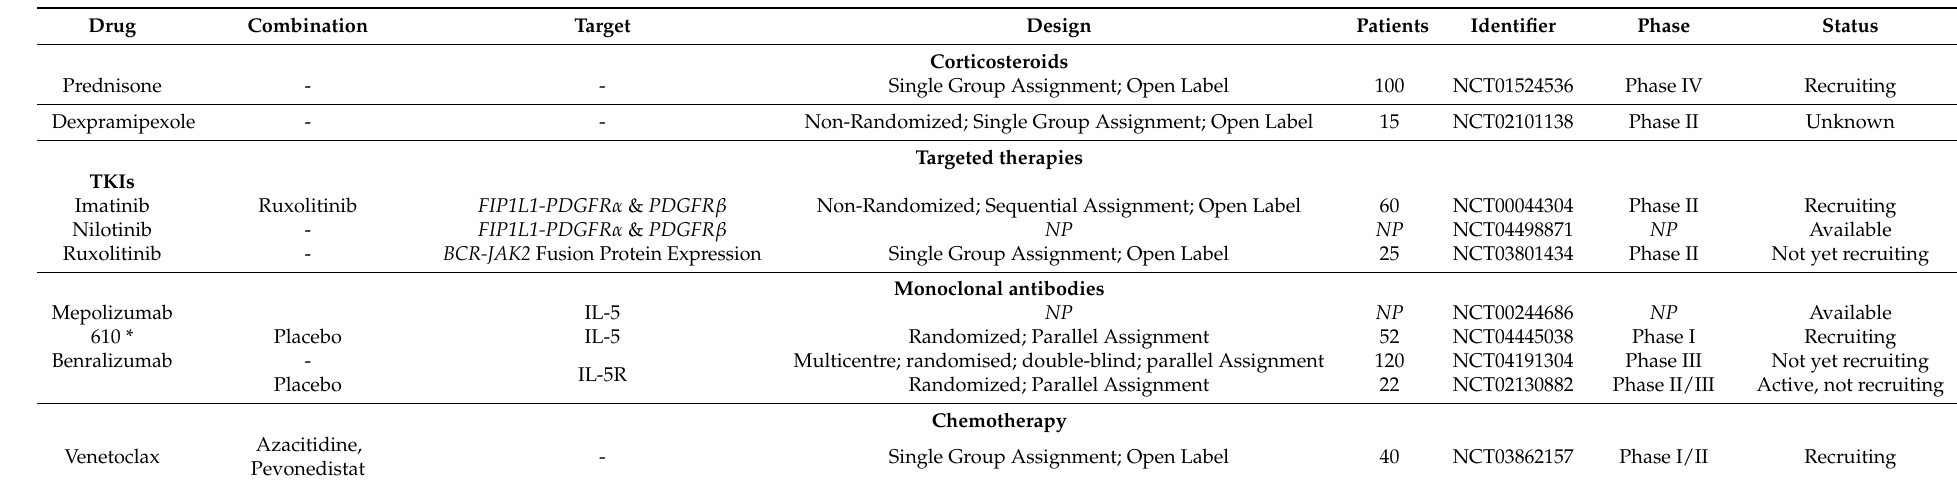
Table 3. Ongoing clinical trials for eosinophilic